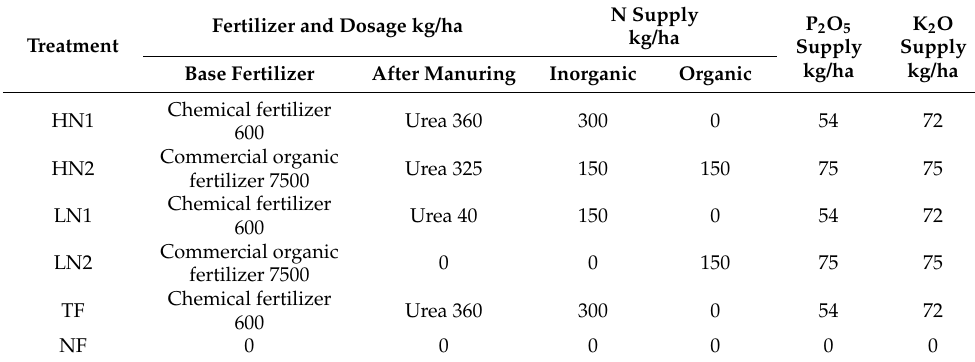
Table 1. N application in the different